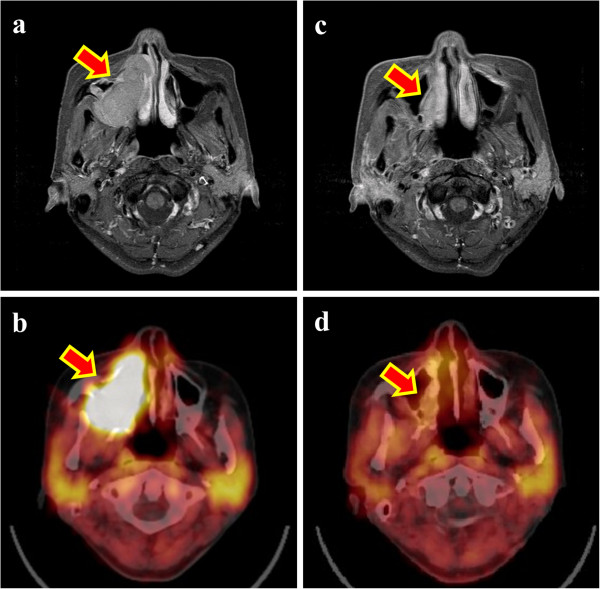
A 49-year-old female who received 57.6 GyE for paranasal sinus cancer. The arrows indicate the tumors. a. Magnetic resonance imaging (MRI) showed a 53 × 44 mm mass in the paranasal sinus region. b. A methionine (MET)-PET/CT image prior to treatment demonstrated a high accumulation mass in the region shown in the MRI. c. MRI revealed tumor shrinkage 44 days after carbon ion radiotherapy. d. The MET-PET/CT image after the treatment demonstrated decreased MET uptake.